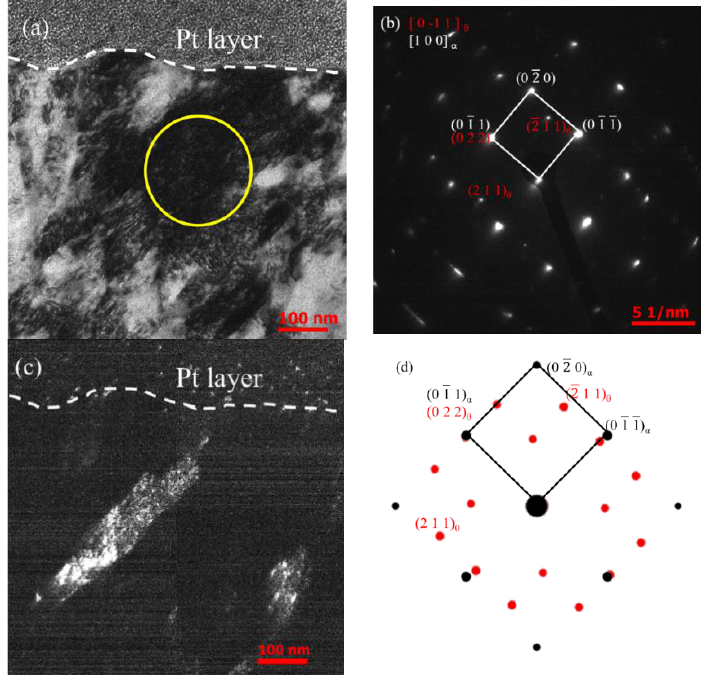
Figure 10. The ( a ) BF image of another area in the WEL-interface TEM specimen; ( b , d ) SAD pattern and indexed pattern, respectively, of the region enclosed in the circle shown in ( a ). The DF image in ( c ) is obtained from the ( 211 ) reflection of cementite.